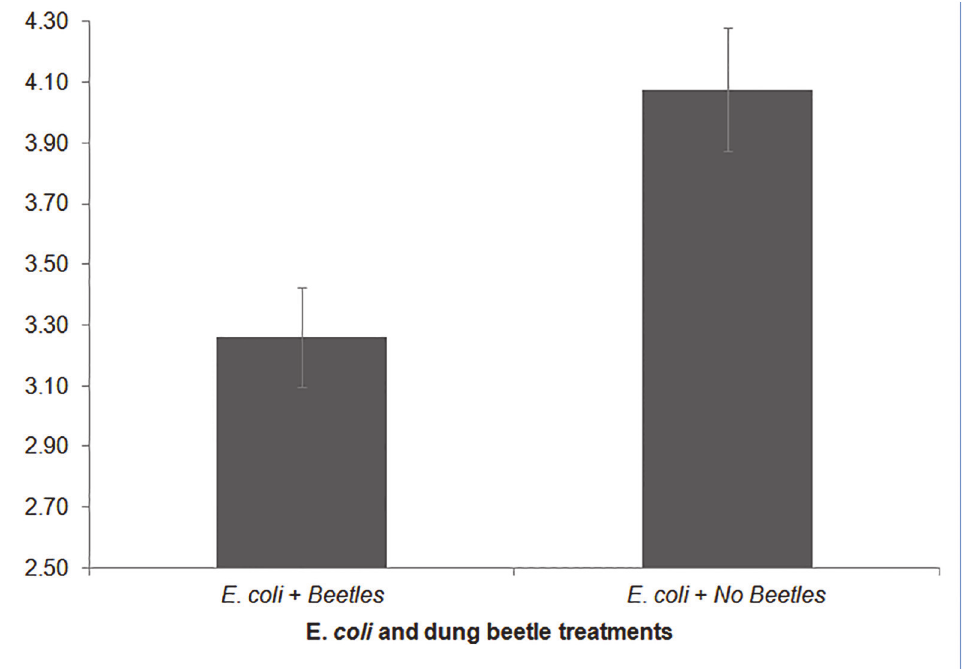
Fig 2. Laboratory experiment 1- Dung beetles drive number of E. coli colonies. Bacteria (log CFU/g, population values rank transformed) from soil samples subjected to different treatment combinations of beetles, and deer scat. Soil from microcosms including E . coli + dung beetles had significantly fewer bacterial colonies of than soil from microcosms containing E . coli + NO beetles ( F (2,9) = 7.757; P = 0.05). (Shown with means and SE